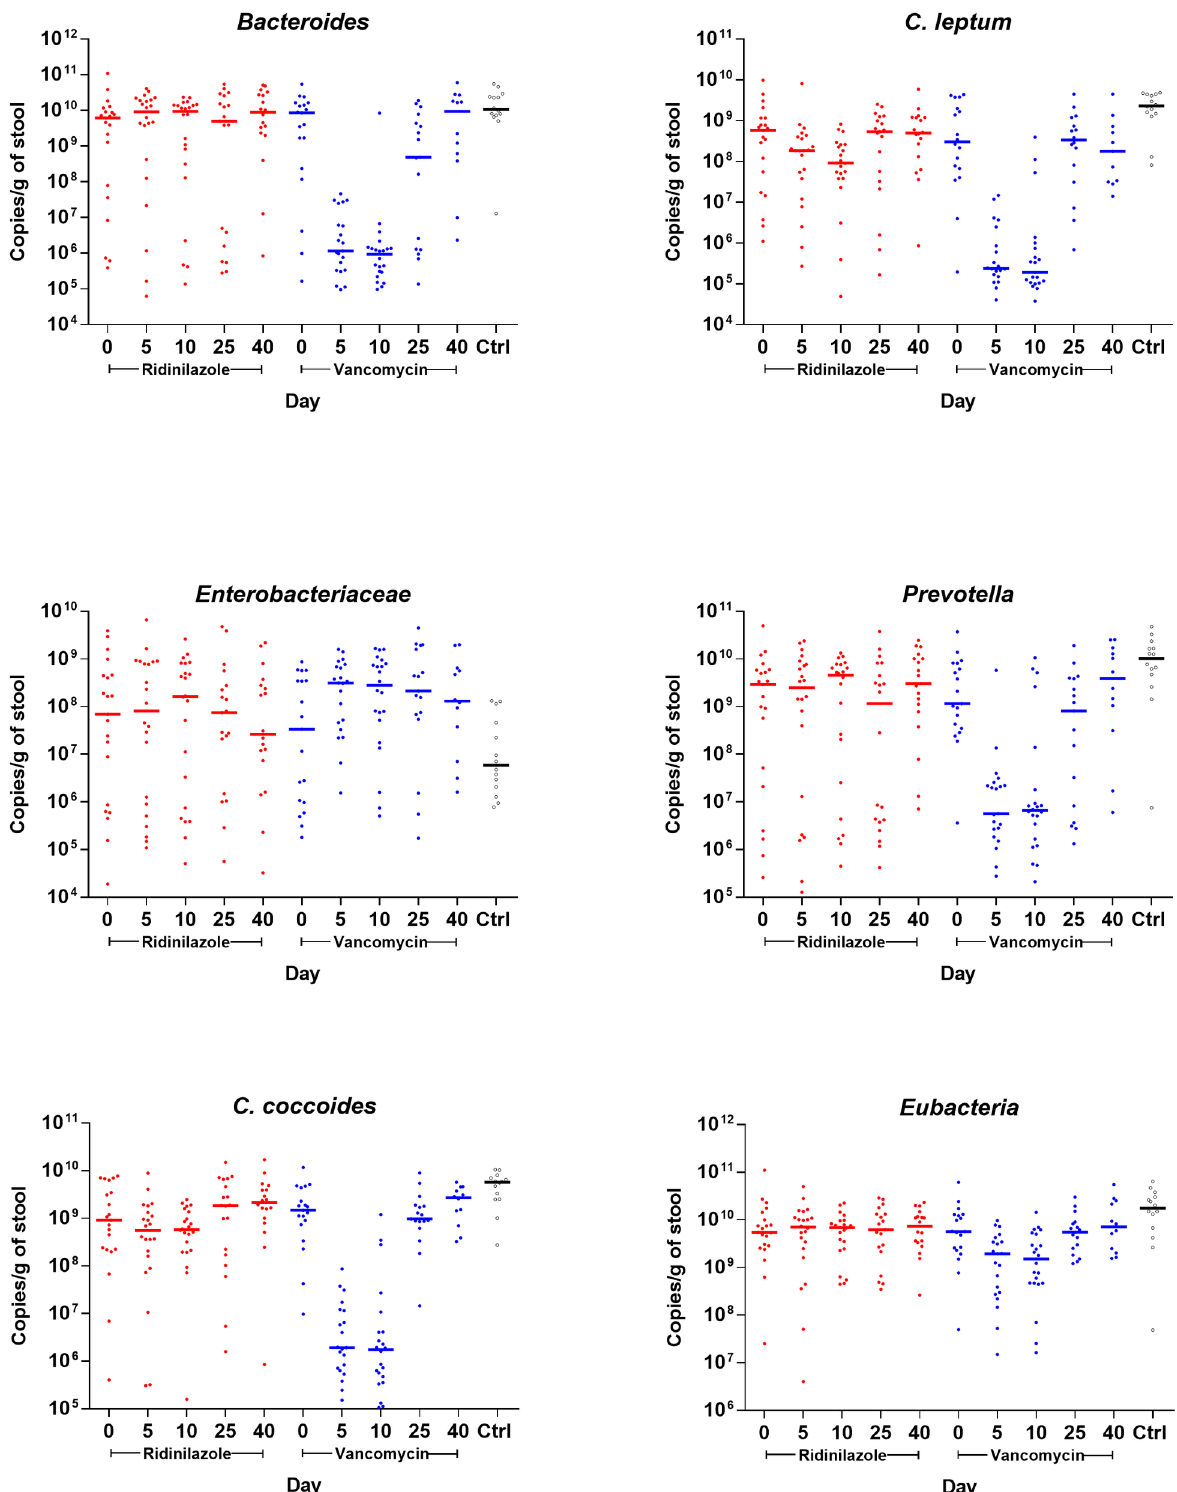
Fig 2. Microbiota levels belonging to different taxonomic groups measured by qPCR in samples from study participants and 14 healthy controls. Red circles represent participants treated with ridinilazole and blue circles represent participants treated with vancomycin. Bolded bars represent the median of all samples at that time